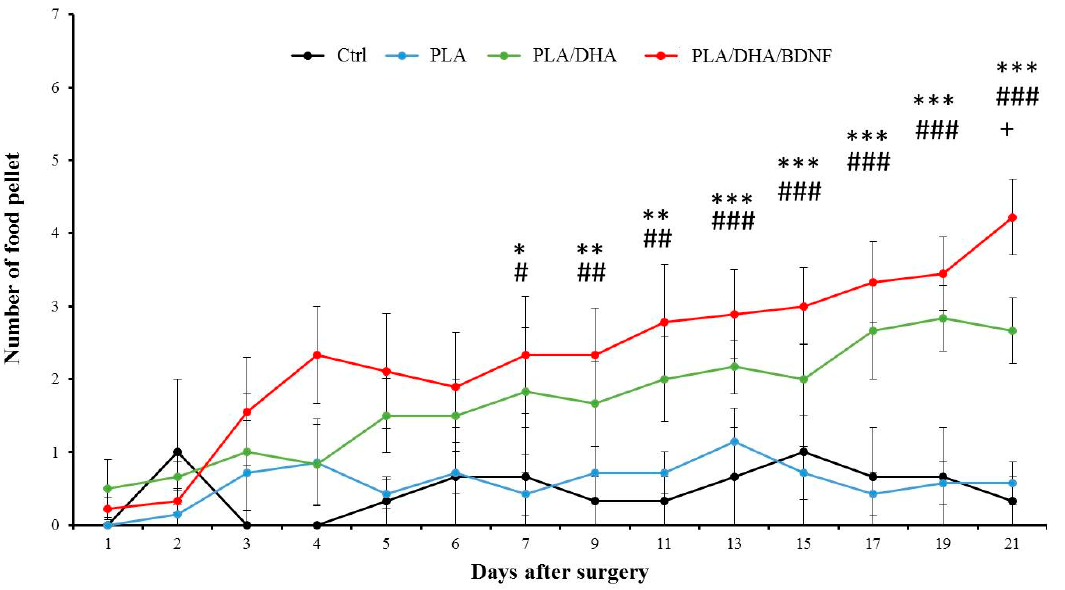
Figure 8. The evaluation of neurological function recovery by the Motaya staircase test. * p < 0.05, ** p < 0.01, *** p < 0.001 PLA/DHA/BDNF vs. control; # p < 0.05, ## p < 0.01, ### p < 0.001 PLA/DHA/BDNF vs. PLA; + p < 0.05 PLA/DHA/BDNF vs. PLA/DHA. The Ctrl is control group.